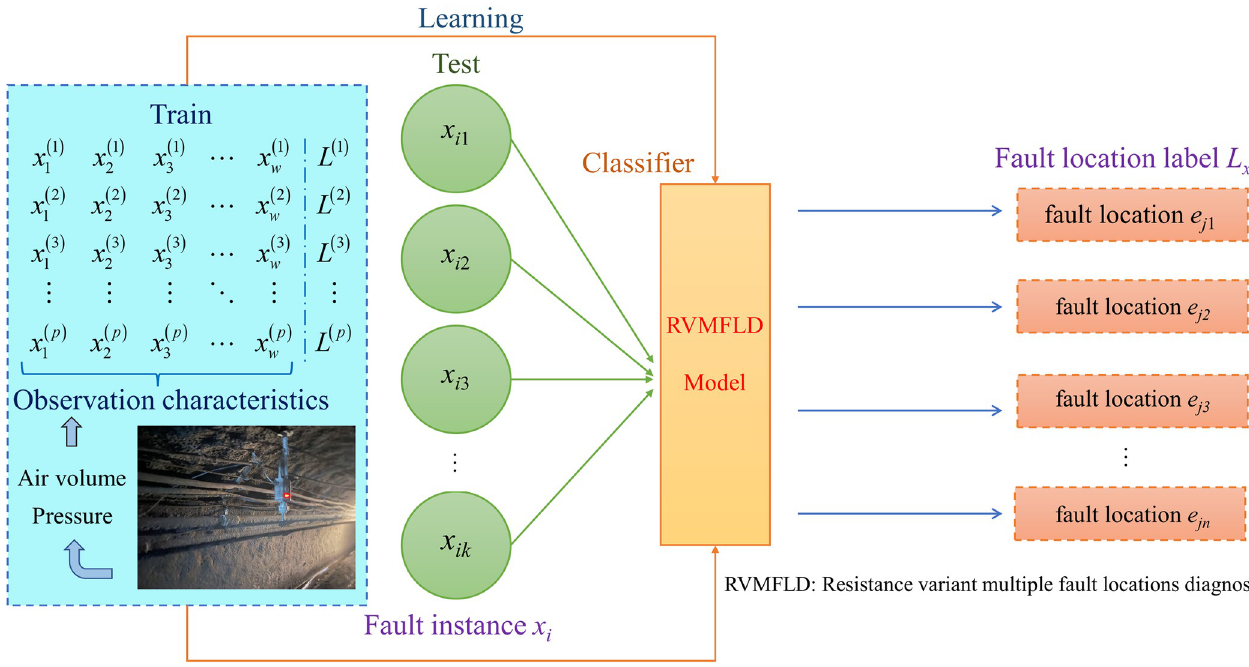
Fig 2. The machine learning model of the resistance variant for multiple fault location diagnoses.